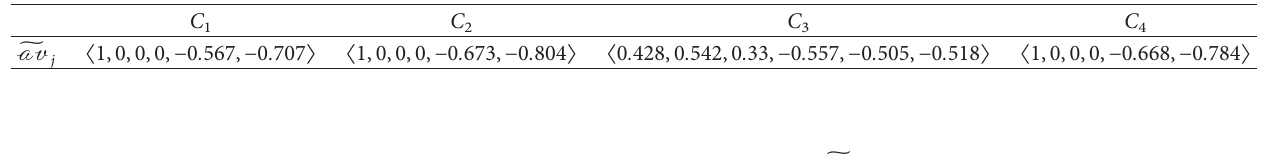
Table 9: The score function values of x